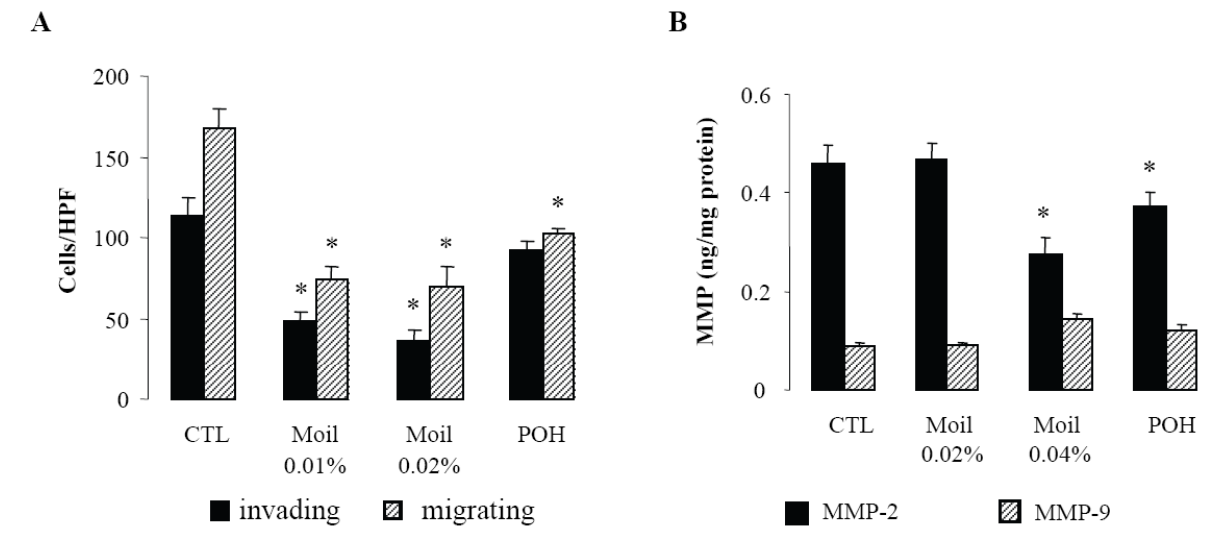
Figure 1. Mastic oil effects on tumor cell invasion/migration and MMP expression. ( A ) Mastic oil attenuates tumor cell invasion and migration. Serum starved LLC cells were treated with Moil (0.01–0.02% v/v), POH (0.5mM) or vehicle (CTL) for 2 h and then loaded onto BD Matrigel Invasion or Control chambers. The lower chambers were filled with complete medium containing test agents and plates were incubated for 20 h. Migrating cells were counted (200 X magnification, 10 HPF/membrane) and results are expressed as mean ± SEM; n = 9, *P < 0.05 from vehicle. ( B ) Mastic oil effects on MMP-2 and MMP-9 expression. Serum starved LLC cultures were treated with Moil (0.02–0.04 % v/v), POH (1 mM) or vehicle (CTL) for 48 h and supernatants were analyzed for MMP-2 and MMP-9 levels by ELISA. Results were normalized to total protein and are expressed as mean ± SEM; n = 12, *P < 0.05 from